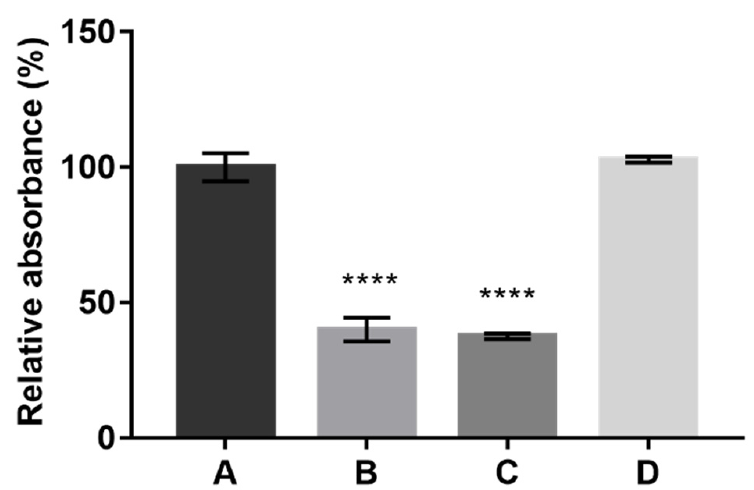
Figure 1. Relative absorbance (%) obtained from the sum of the absorbance values at the three wavelengths (400, 470, and 500 nm) after 12 days of fermentation under submerged fermentation conditions, using the culture media A, B, C, and D. Values are the mean ± SD ( n = 3). Statistical analysis was performed by one-way ANOVA using Tukey’s multiple comparisons test (**** p < 0.0001).